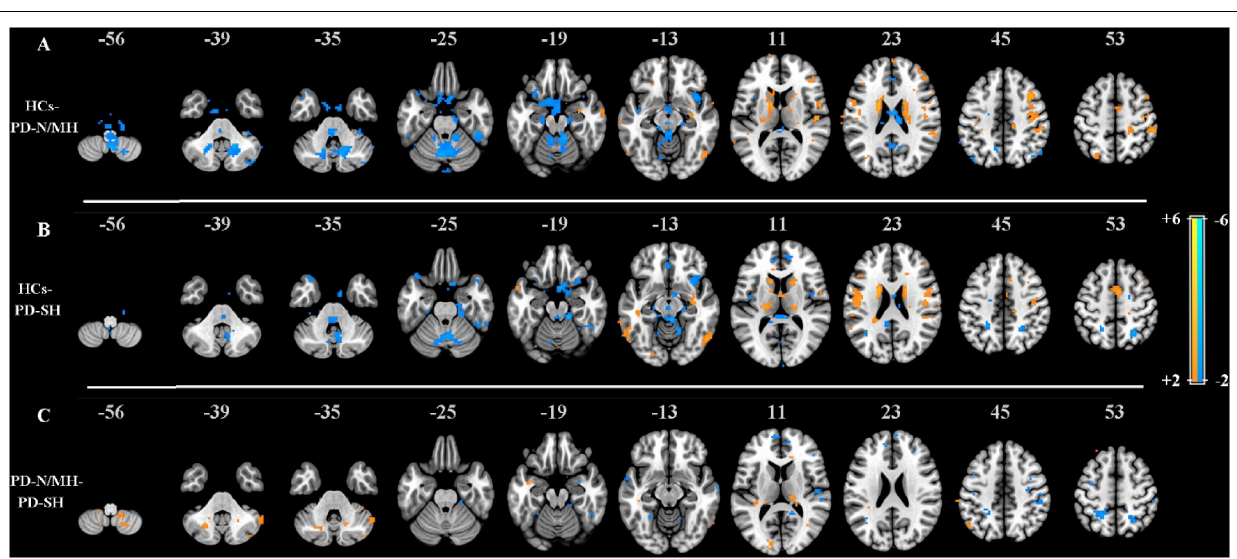
FIGURE 7 | (A) Z–statistical difference maps between the HCs (warm color) and PD-N/MH (cool color) ( n = 15, z > 2.0, p < 0.05, Tukey-Kramer correction). (B) Z–statistical difference maps between the HCs (warm color) and PD-SH (cool color) ( n = 15, z > 2.0, p < 0.05, Tukey-Kramer correction). (C) Z–statistical difference maps between the PD-N/MH (warm color) and PD-SH (cool color) ( n = 15, z > 2.0, p < 0.05, Tukey-Kramer